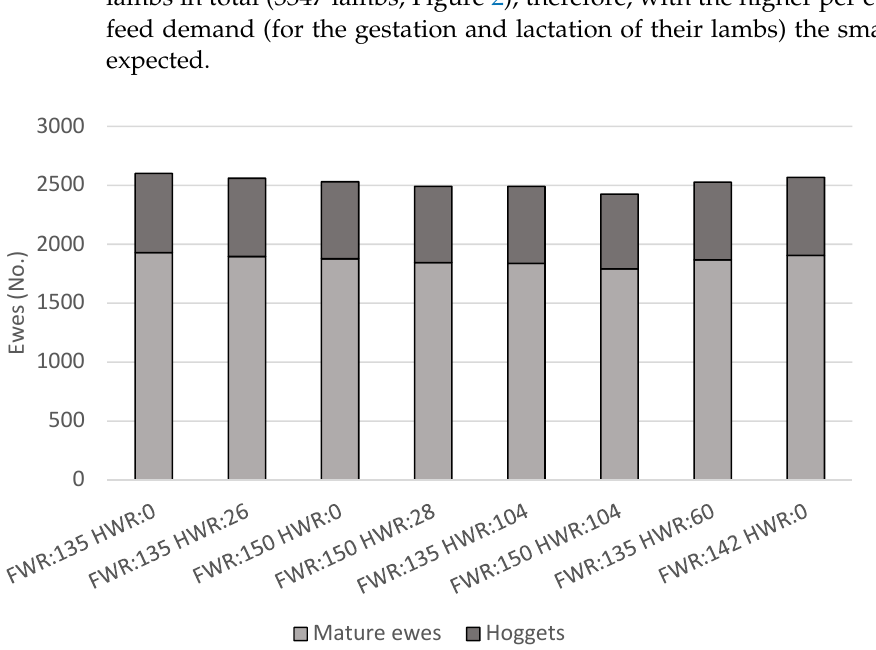
Figure 1. Numbers of mature ewes (2 to 6 years old) and hoggets (1 year old), for scenarios with combinations of varying weaning rates (weaned lambs per ewe that was presented for breeding) of mature ewes (FWR) and hoggets (HWR).